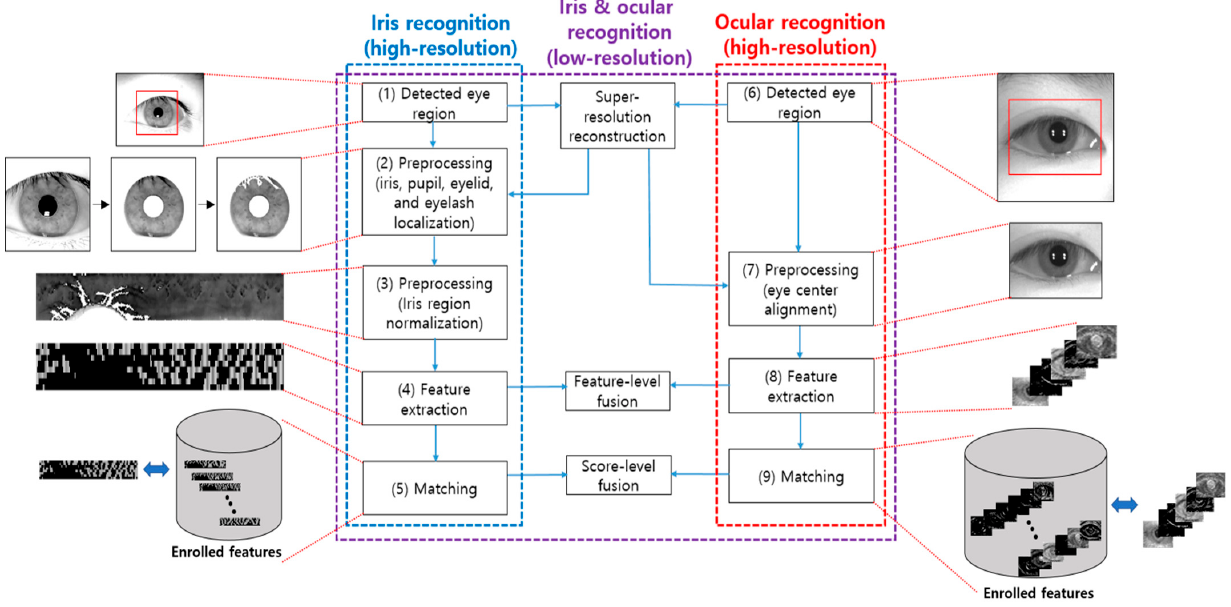
Figure 2. An overview of iris and ocular recognition in high- and low-resolution images. First, in general, traditional high-resolution iris recognition—as shown in the dashed blue box in Figure 2—roughly detects the eye region from the input image using a method, such as the adaptive boosting (Adaboost) eye detector [19] (step (1)); by preprocessing, it then detects the iris, pupil, eyelid, and eyelash regions from the eye region [12] (step (2)); after preprocessing, to remove the eyelid and eyelash regions that impinge on the pupil and iris regions, the iris region is normalized to transform the Cartesian coordinates into polar coordinates (step (3)); based on the normalized iris region, a CNN or filters, such as the Gabor filter, extract the iris code (step (4)); the final step recognizes the iris through pattern matching using various dissimilarity measurements, such as the Hamming dis- tance between the enrolled image’s iris code and that of the image being recognized (step (5)). In iris recognition using the traditional image processing method, the performance depends on how accurately the iris features are extracted. The performance is evaluated through the error equal rate (EER), an indicator widely used in biometrics. When actual recognition is performed, the EER shows the error rate at a point where the false ac- ceptance rate (FAR) equals the false rejection rate (FRR). The FAR is the probability that a subject is incorrectly accepted, and the FRR is the probability that a user is incorrectly rejected as someone else. The studies on iris recognition in high-resolution images can be categorized as image processing, machine learning, and deep learning methods. 2.1.1. Image Processing Method First, Thomas et al. [20] applied iris segmentation for image processing, which bases recognition on a random sample consensus (RANSAC). Then, the preprocessing for iris recognition is completed by transforming the iris region using a rubber-sheet model, which is commonly applied in most approaches for iris recognition. Afterward, the per- formance measurement, based on signals, termed the peak side-lobe ratio (PSLR) is used as the final recognition method. For this, the rubber-sheet image of the iris is transformed into a frequency signal region by the fast-Fourier transform (FFT). Then, the proposed method executes recognition through template matching using the PSLR value as the sim- ilarity measure for the enrolled and recognition images. Tahir et al. [21] proposed a novel method for initially detecting the iris region using a morphological filter to remove re- flected light and a circle-shaped template for the horizontal and vertical axes. First, the